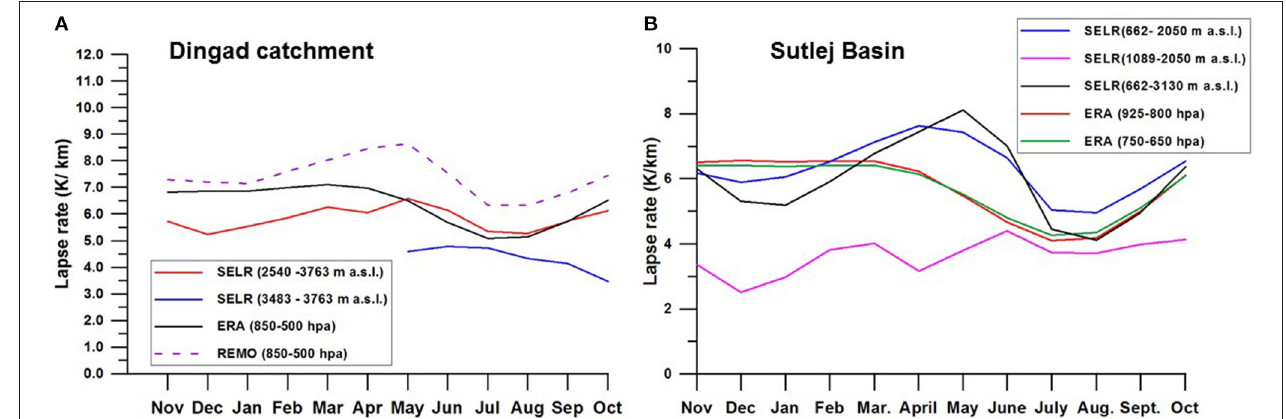
FIGURE 11 | Comparison of ERA–interim free environment lapse rate with SELR of (A) Dingad catchment and (B) Sutlej–Beas basin. Free Environment lapse rate derived from REMO RCM for Dingad basin is also